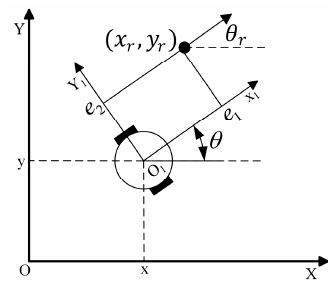
Figure 1. Diagram of trajectory tracking.